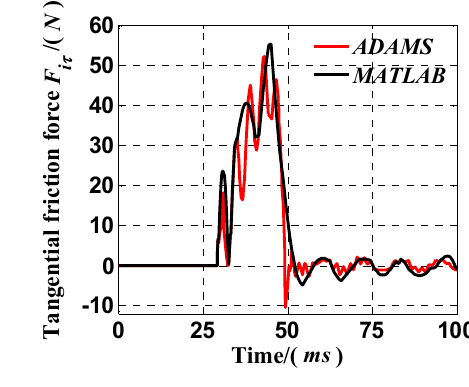
( b ) Collision force curves for the tangential fric- ( a ) Collision force curves for the normal force tion force Figure 12. Collision force curves of the blueberry branch.